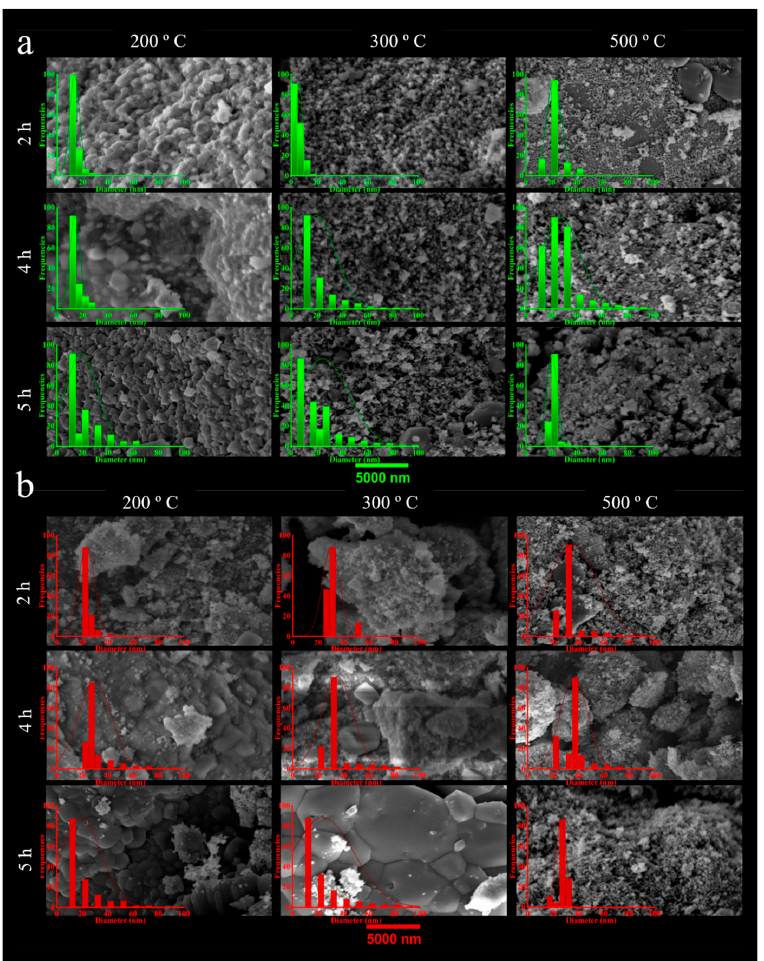
Figure 4. Scanning electron microscopy (SEM) of the nanoparticles calcinated at different tempera- tures (200, 300, and 500 ◦ C) and times (2, 4, and 5 h): ( a ) GS-NPs profile using aqueous extracts of PDL and ( b ) CS-NPs profile using